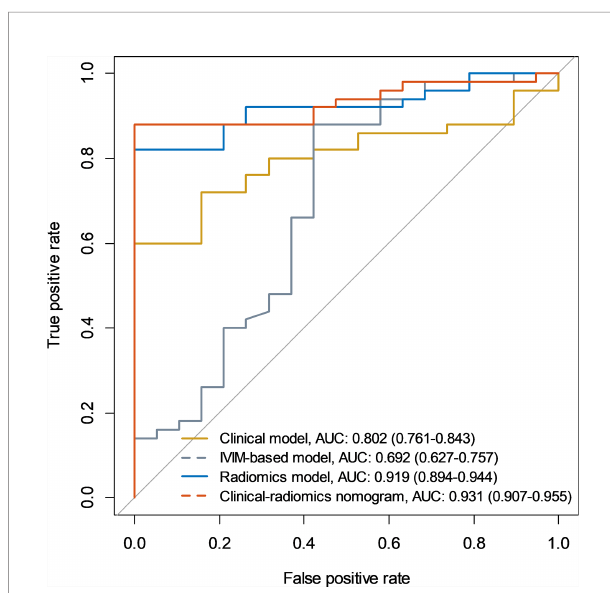
FIGURE 3 | Receiver operating characteristic curves of the clinical model, IVIM-based model, radiomics model, and clinical-radiomics